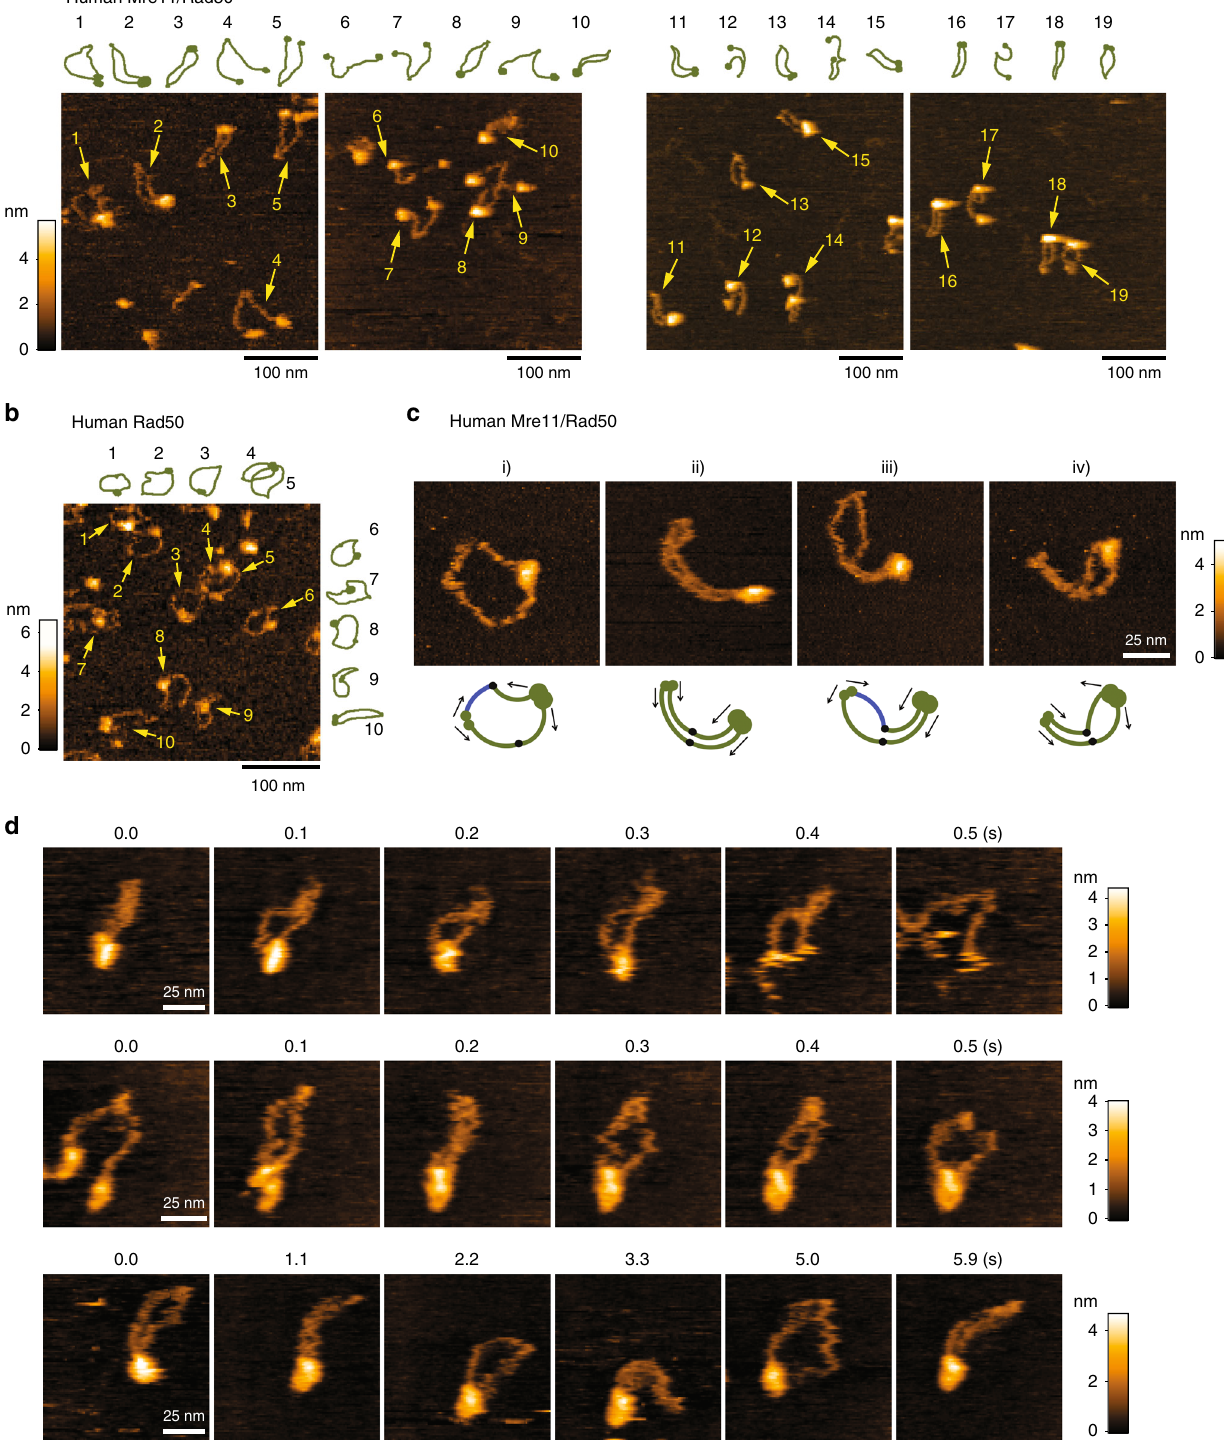
Fig. 2 Structural variations of human Mre11/Rad50 and their exchanges video-imaged by high-speed AFM. a Landscape images containing the ring and head-open structures of human Mre11/Rad50 (left: − ATP; right: + ATP). Presumed structures of Mre11/Rad50 molecules are depicted with a dark-green line around images. b A landscape image of human Rad50 ( − ATP). c Representative ring structures observed for human Mre11/Rad50 ( − ATP). A schematic diagram of presumed structures is shown below. In (i) and (iii), one of the arms (blue line) seemed to be turned over and twisted 180 degrees at a particular position (black oval). d Movement of human Mre11/Rad50 was real-time imaged by directly adding proteins into the imaging chamber while imaging at 100 ms per frame ( + ATP). Scan size, 100 × 100 nm. Upper: sequential images of Mre11/Rad50 opening the ring. Middle: the same Mre11/ Rad50 closing the ring. Lower: selected images from the movie showing the ring and the closed/arm-parallel